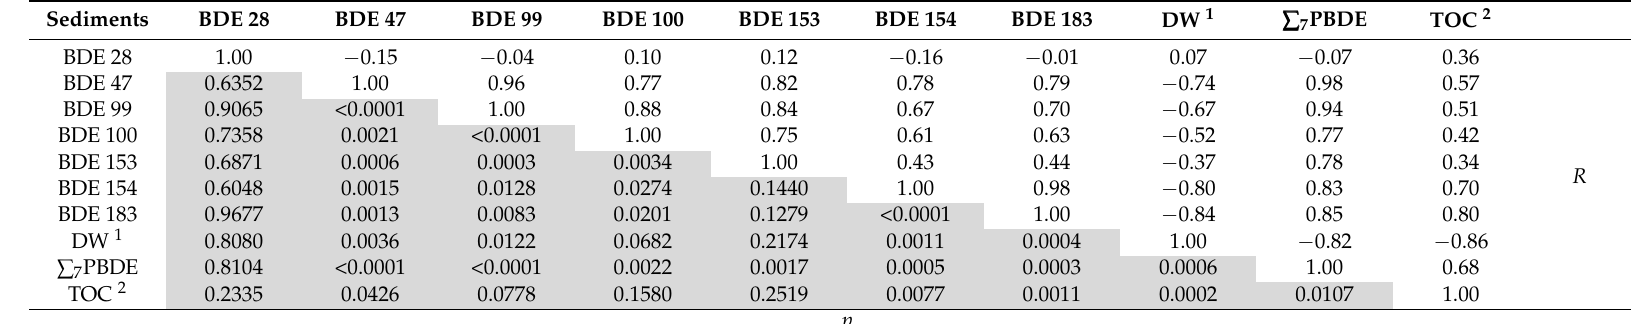
Table 4. Pearson correlation coefficients and p -values calculated for PBDE concentrations, the content of dry material, and the total organic carbon analyzed in sediment